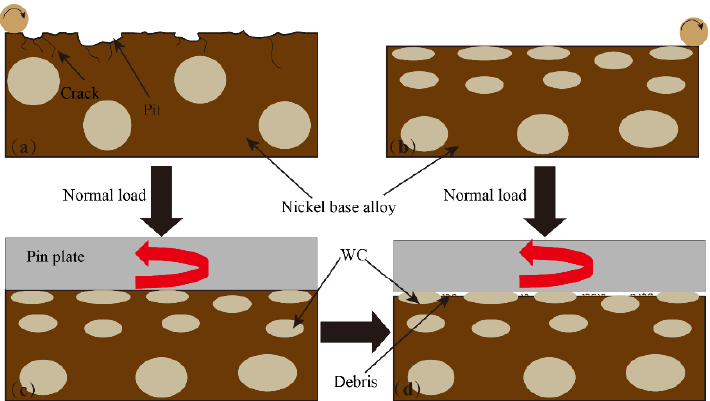
Figure 13. Wear resistance mechanism diagram pre and post coating strengthening: ( a , b ) pre and post HT + UDR; ( c , d ) pre and post coating wear.